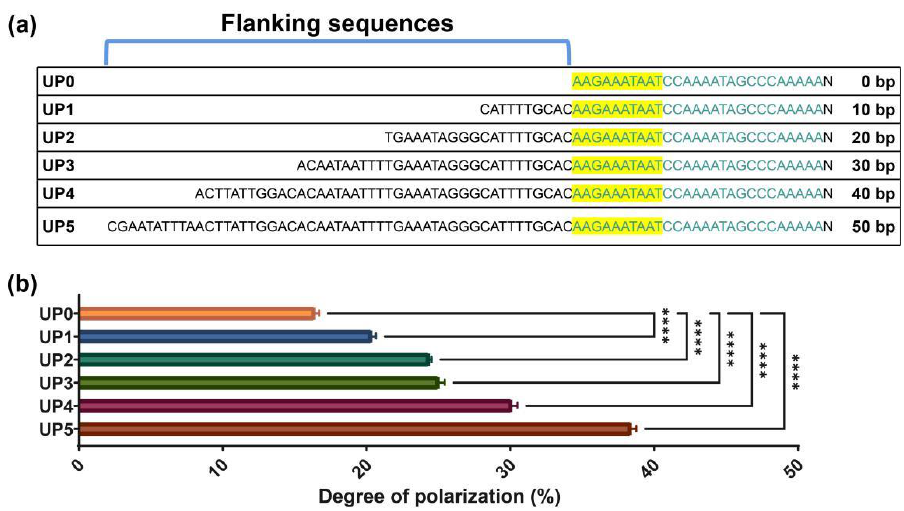
Figure 4. The influence of different flanking sequence lengths on the interaction between the promoters and α -CTD. ( a ) Illustration of the synthetic promoters with different flanking sequence lengths. ( b ) Interaction between the synthetic promoters and α -CTD were investigated by FP, and the degree of polarization was calculated. Results are expressed as mean of replicates; columns with **** represent statistically significant differences between groups at p < 0.0001.